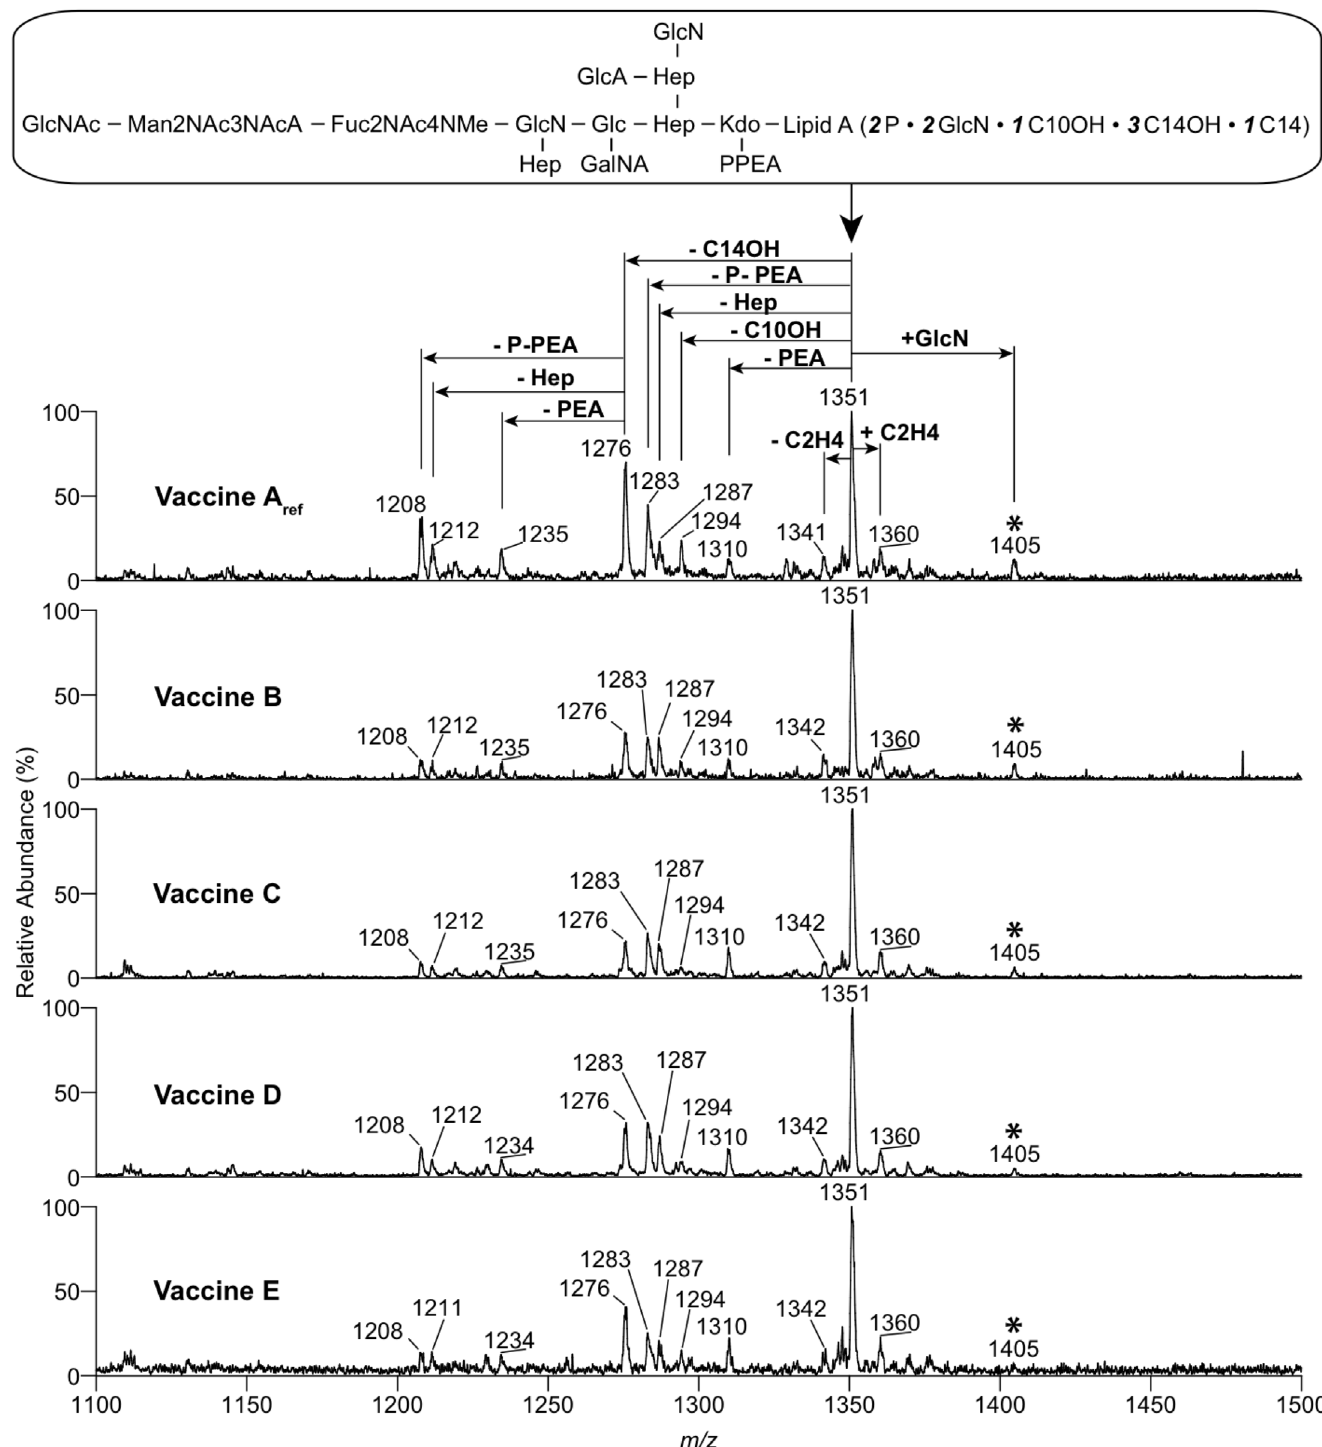
Fig 5. Negative-ion ESI mass spectra of LPS isolated from wP vaccine preparations A ref — E. The triply charged (M-3H)3- molecular ion regions of the mass spectra of LPS from vaccine preparations A ref , B, C, D and E are shown. The box on top of the mass spectra contains a simplified representation of the chemical structure of the LPS from B . pertussis reported previously [35]. This structure has been assigned to the ion of m/z 1351. The ions highlighted by an asterisk correspond to LPS with a glucosamine substitution of the lipid A phosphate. Abbreviations: Kdo, 3-deoxy-D-manno- oct-2-ulosonic acid; Hep, L-glycero-D-manno-heptose; Glc, glucose; GlcN, glucosamine; GlcNAc, N-acetyl glucosamine; Fuc2NAc4NMe, 2-acetamido-